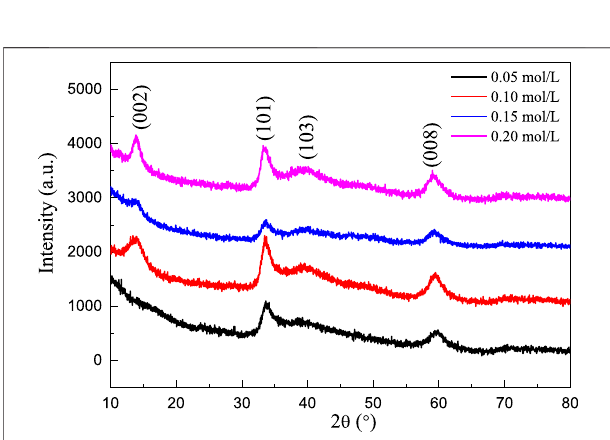
FIGURE 4 | XRD patterns of MoS 2 /C composites prepared by the hydrothermal calcination method with the different concentrations of molybdenum chloride including 0.05, 0.10, 0.15, and 0.20 mol/L.